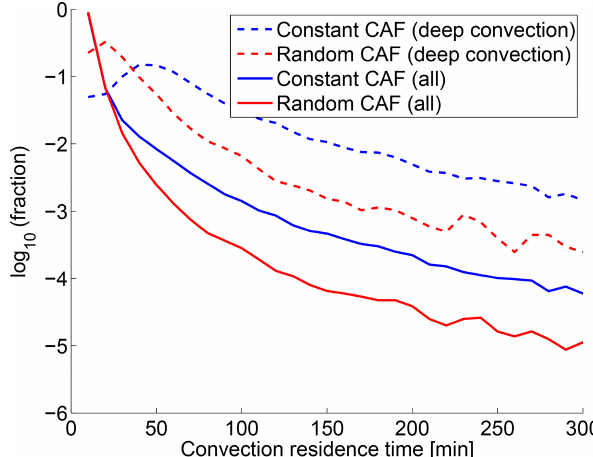
Figure 12. Frequency distribution of the residence times of the tra- jectories between entrainment and detrainment simulated by the two parameterizations for the vertical updraft velocity. The fraction of all events with a given duration is shown in 10min bins. Solid lines show the distribution for all convective events, while dashed lines show the contribution from deep convective events (detrain- ment above